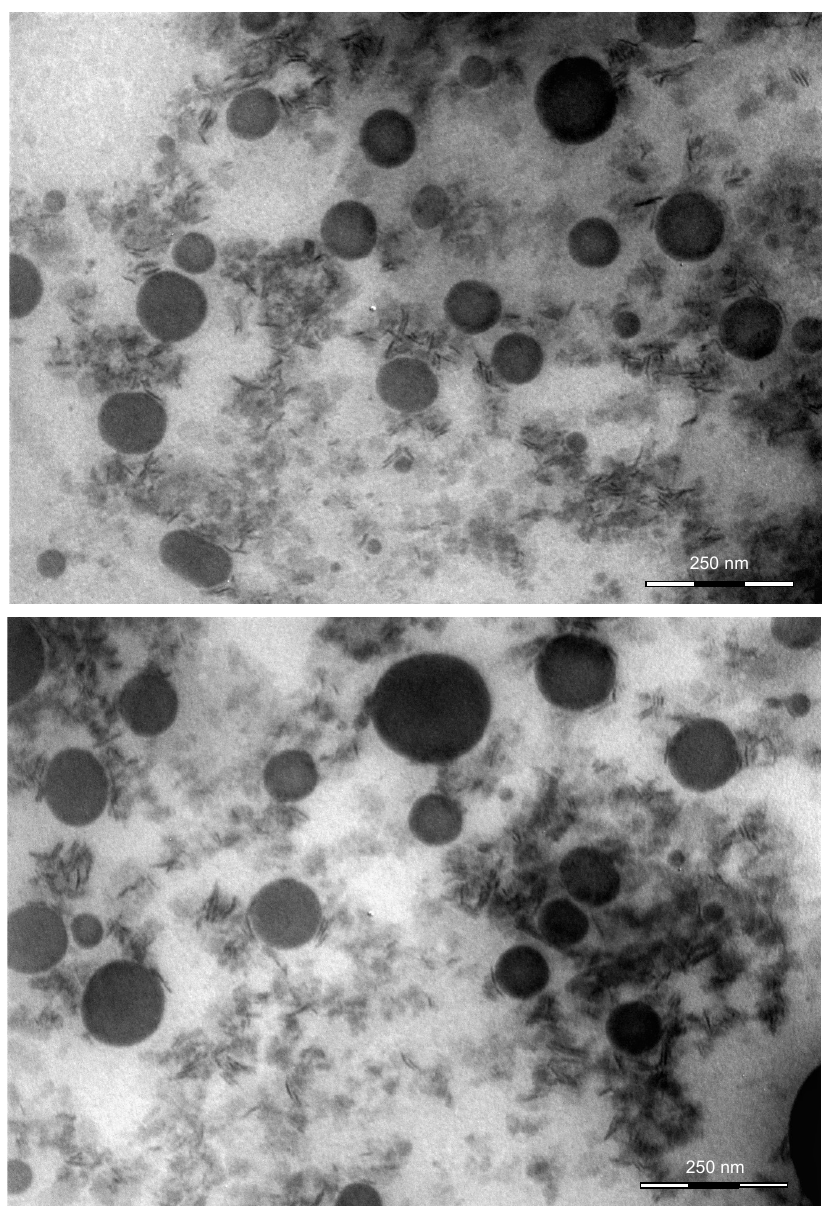
Figure 5. Pictures of K-NLCs obtained by transmission electron microscopy. Scale bars = 250 nm.